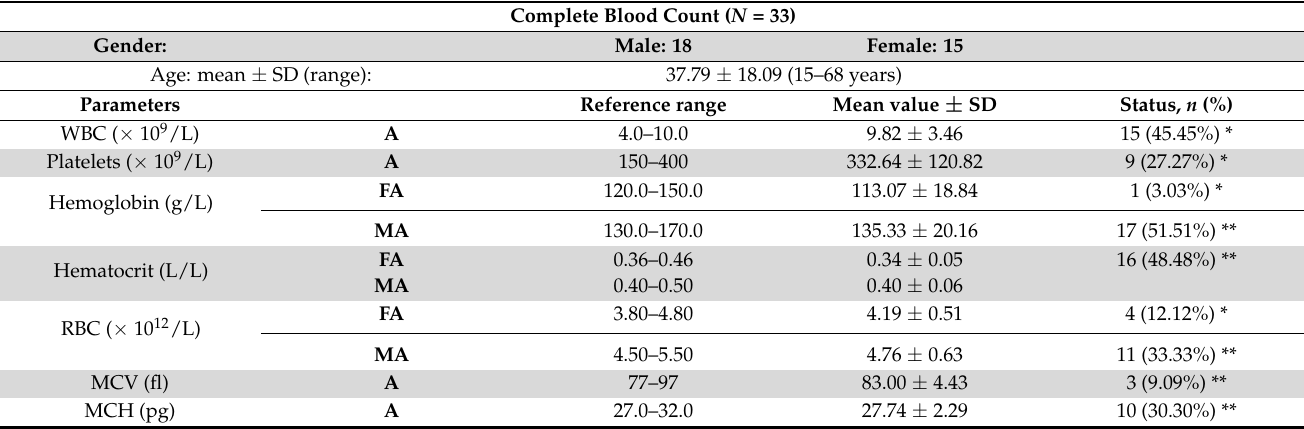
Table 5. Blood parameters of sarcoma